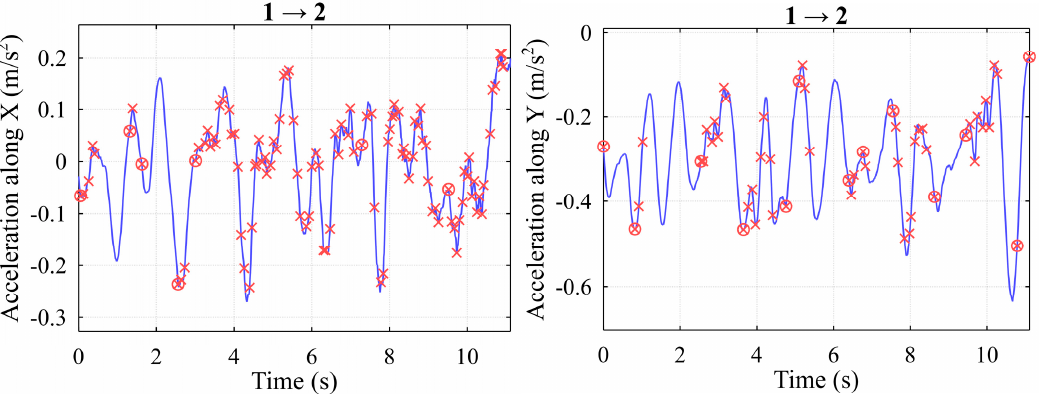
decreased by four as well.